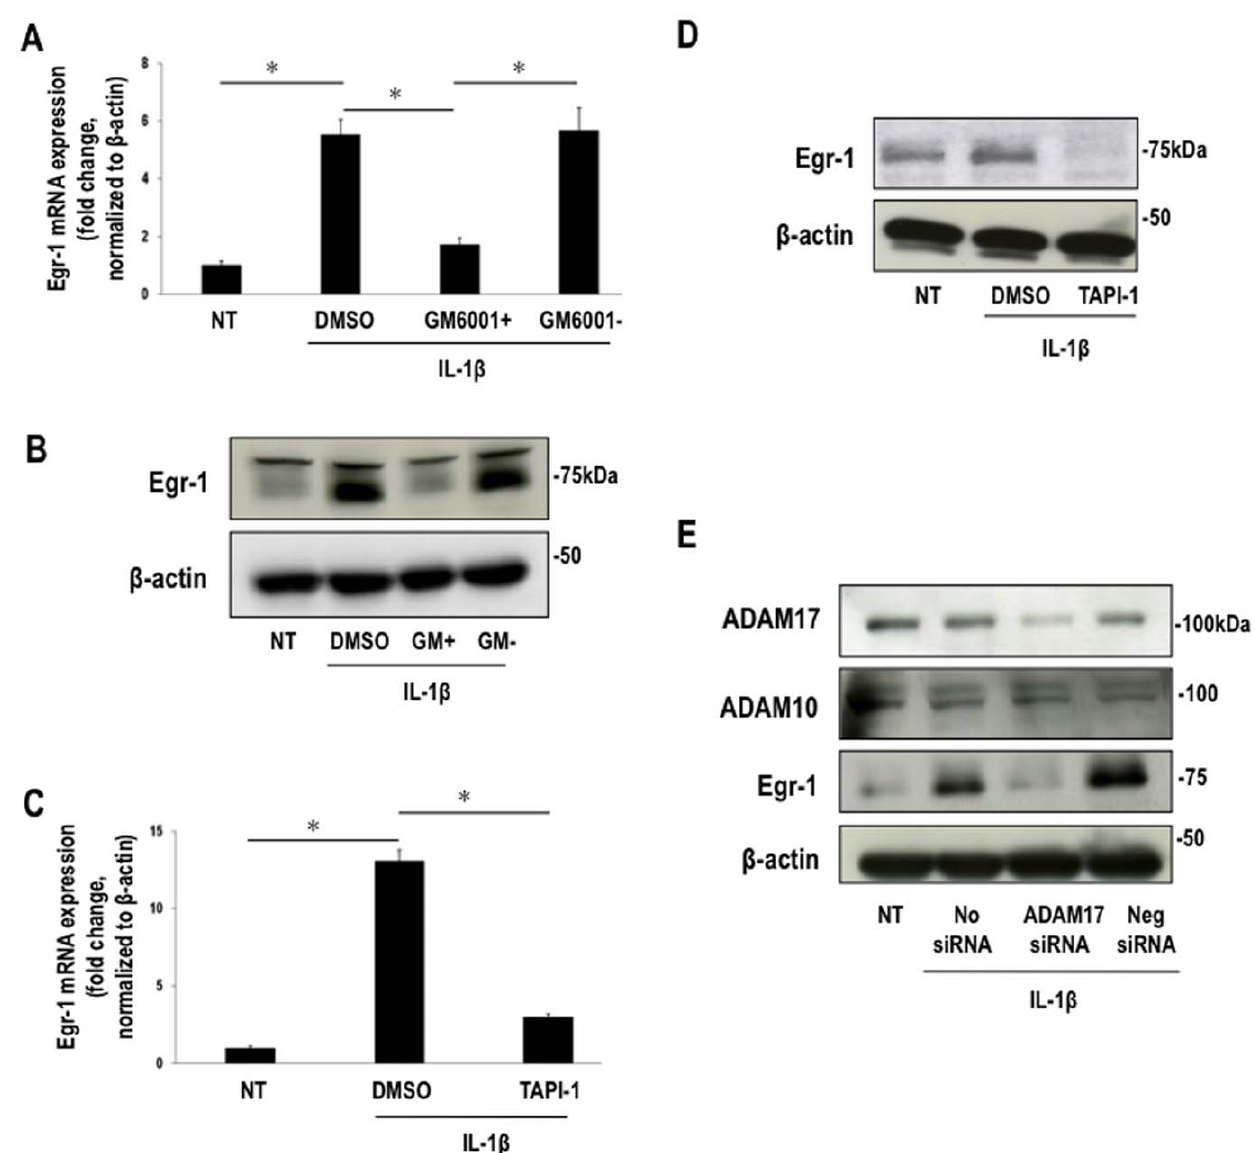
Figure 1. IL-1beta-inducible Egr-1 expression is MMP/ADAM-dependent. Growth-quiescent SMCs were treated with MMP inhibitor GM6001 + (25 m M) and TAPI-1 (10 m M) for 30 min before stimulation with IL-1beta (10 ng/ml) for another 30 min (unless indicated otherwise). ( A ) Egr- 1 mRNA levels in GM6001 + or GM6001- treated SMCs treated with IL-1beta by qPCR. Data were normalized to beta-actin. ( B ) Western blotting for Egr- 1 or beta-actin in total extracts of SMCs treated with GM6001 + or GM6001-. ( C ) Egr-1 mRNA levels in TAPI-1 treated SMCs treated with IL-1beta by qPCR. Data were normalized to beta-actin. ( D ) Western blotting for Egr-1 or beta-actin of total extracts of SMCs treated with TAPI-1. DMSO was used as a carrier. ( E ) Western blotting for ADAM17, ADAM10, Egr-1 or beta-actin of total extracts of SMCs transfected overnight with ADAM17 siRNA (0.1 m M) and treated with IL-1beta for 30 min.